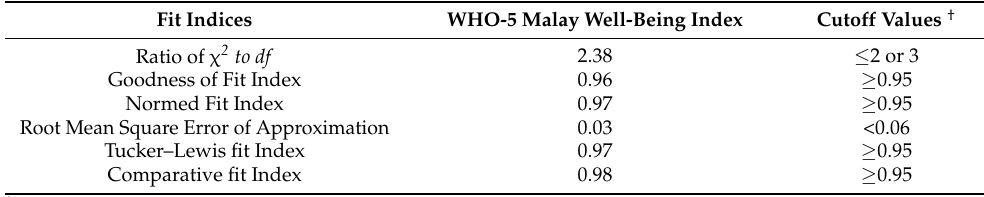
Table 2. Model fit indices of the WHO-5 Malay and their recommended cut-off